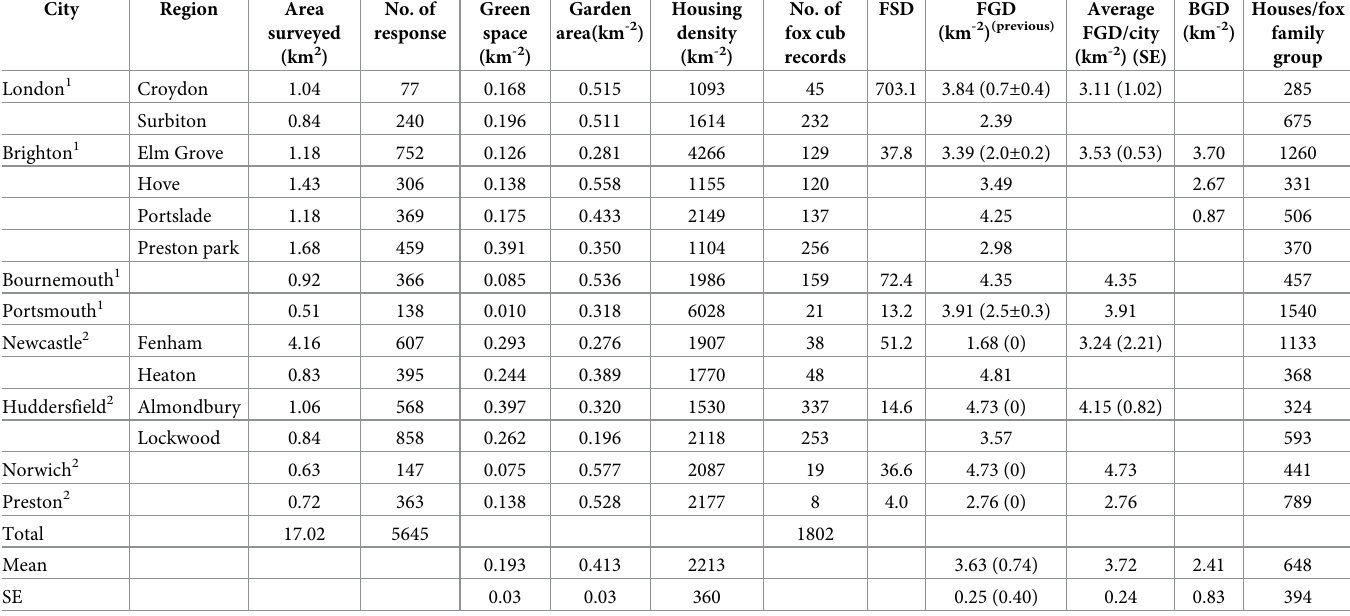
Table 2. Fox and badger group density and landscape composition of study